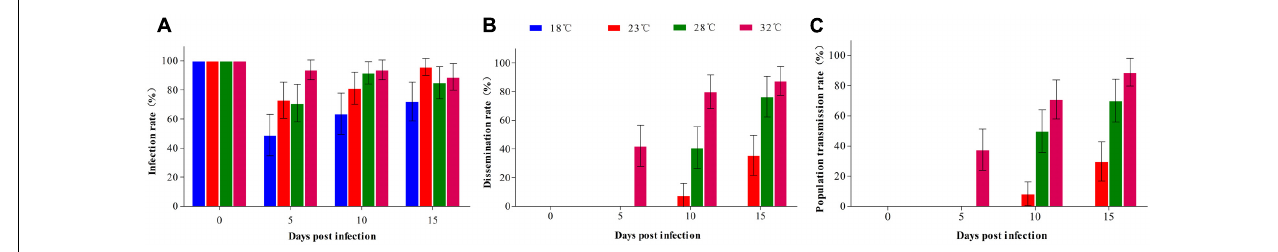
FIGURE 1 | Vector competence of Ae. albopictus orally infected with DENV-2 at different temperatures. Ae. albopictus orally infected with DENV-2 were reared at 18, 23, 28, and 32 ◦ C. The midguts, ovaries, and salivary glands of mosquitoes reared at each temperature were dissected at 0, 5, 10, and 15 days post-infection and detected by PCR. (A) Infection rate (IR): no. positive midguts/total no. midguts; (B) Dissemination rate (DR): no. positive ovaries/no. positive midguts; (C) Population transmission rate (PTR): no. positive salivary glands/total no. mosquitoes. Error bars represent 95% confidence interval (CI).